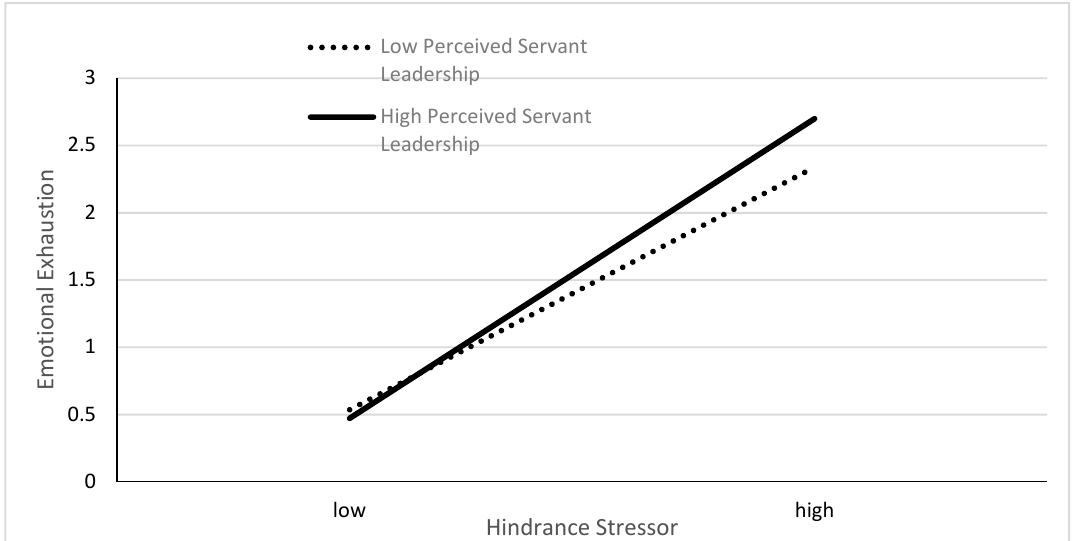
Figure 2. Moderating effect of perceived servant leadership on the relationship between challenge stressor and emotional exhaustion.